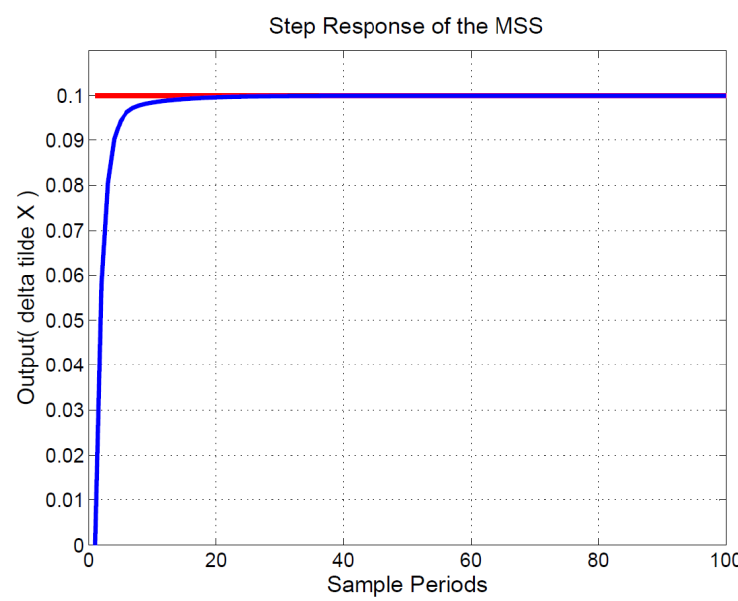
Figure 7. ( K d , ϕ , K i ) iterative curve. Figure 7. ( K d , φ , K i ) iterative curve.